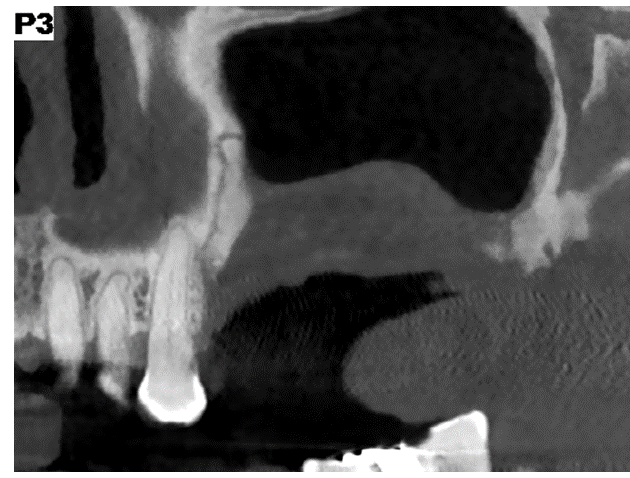
Figure 12. CBCT view at one year.